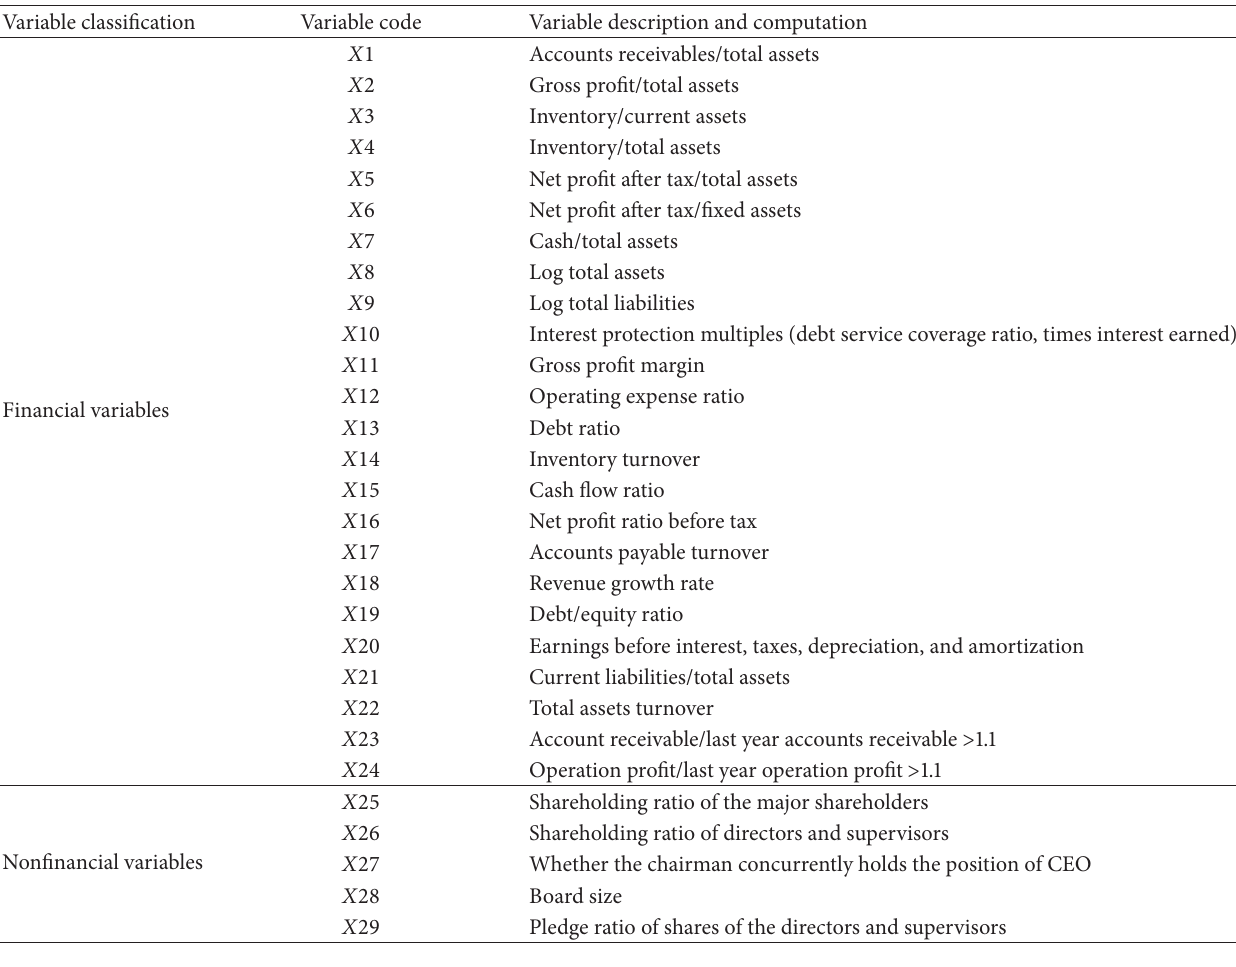
Table 8: Selection of the research variables.